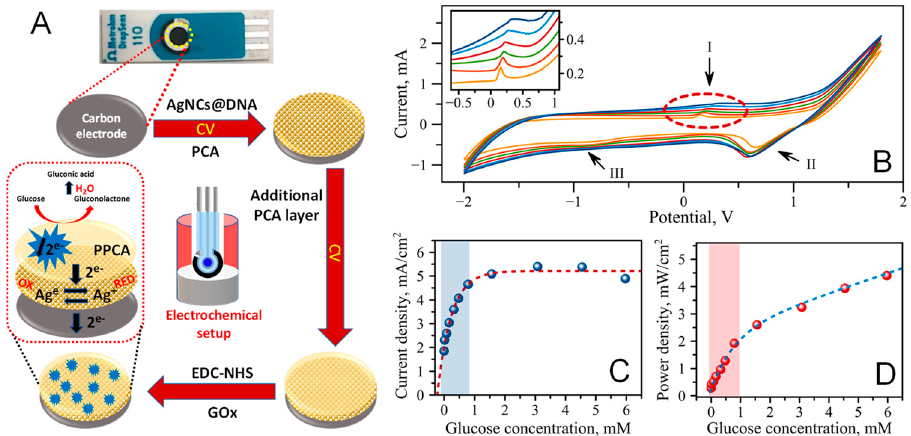
Figure 3. ( A ) Design of the single-enzyme, AgNCs-based three-electrode biosensing system, and ( B ) cyclic voltammograms of the modified electrodes in the solution with varied concentrations of glucose ranging from 0 to 0.5 mM ( orange: 0 mM; red: 0.1 mM; green: 0.2 mM; ruby: 0.3 mM; light blue: 0.4 mM; and blue: 0.5 mM); arrows indicate the positions of three prominent peaks: (I) E a = 0.11 V, (II) E 1c = 0.73 V, and (III) E 2c = − 0.75 V. Parameters: PBS, v = 100 mV/sec; E range = from − 2.0 to 1.8 V; Inset: enlarged portion of CV curves at E a = 0.11 V; ( C ) current density dependence on glucose concentration (dashed nonlinear regression curves are plotted as a guide to the eye); ( D ) power density, P in mW/cm 2 , dependence on glucose concentration.